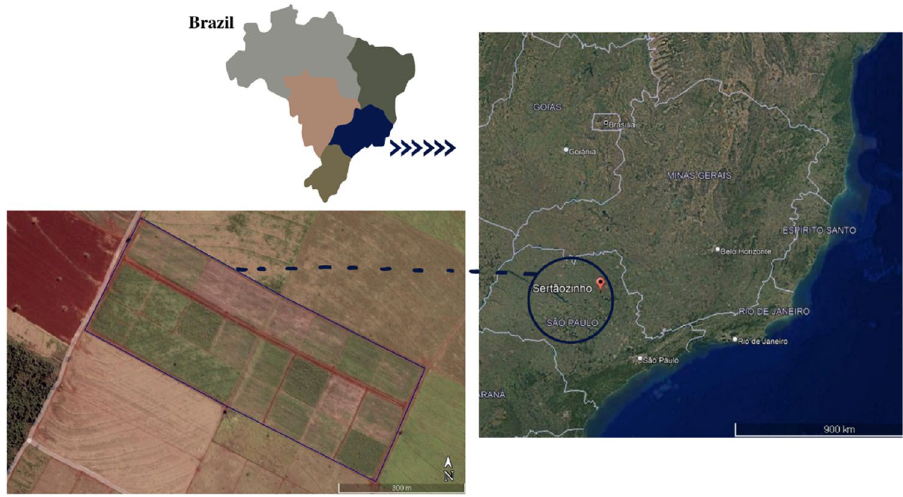
Figure 2. Localization and representation of the area of the experiment carried out in the study. Google Earth version Pro was used to construct the map (http:// www. google. com/ earth/ index.